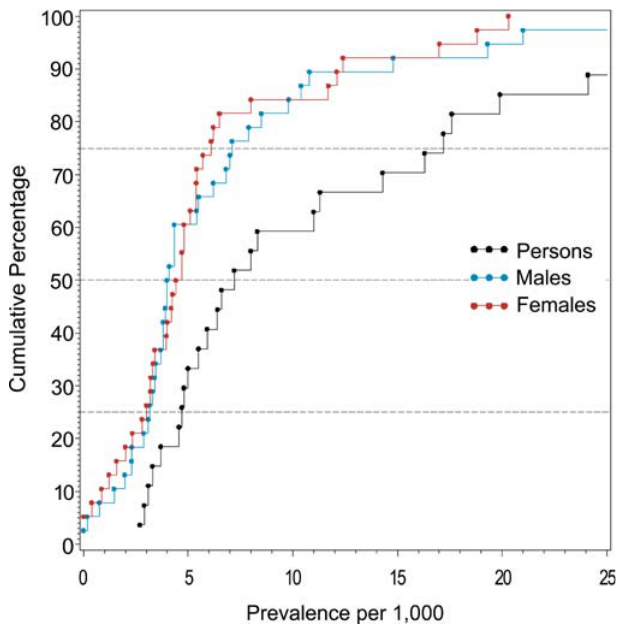
Figure 5. Cumulative Plots of the LMR Estimates per 1,000 by Sex DOI: